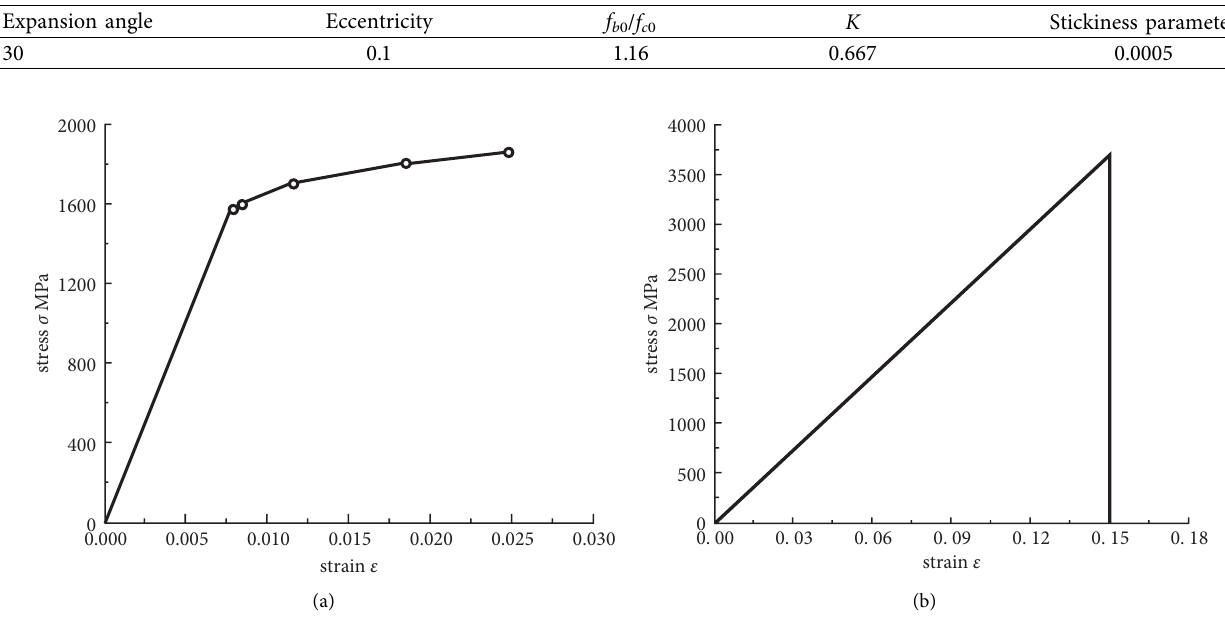
Figure 17: Stress-strain curve of prestressed steel strand and carbon fiber. (a) Prestressed steel strand. (b) Carbon